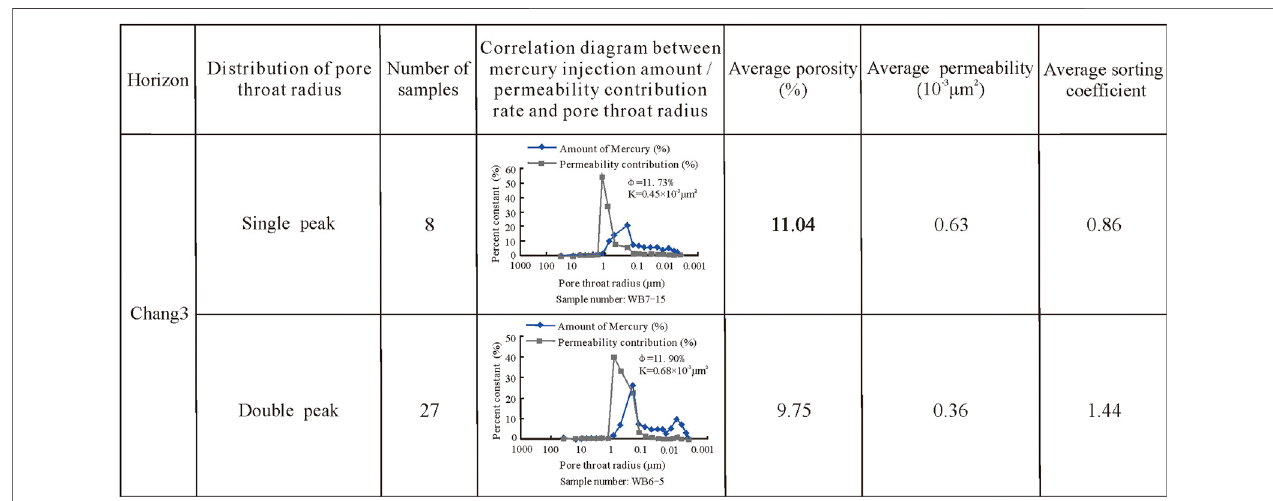
FIGURE 7 | Average of porosity, permeability, and sorting coef fi cient of single and double peak of the Chang 3 Member in the study area.